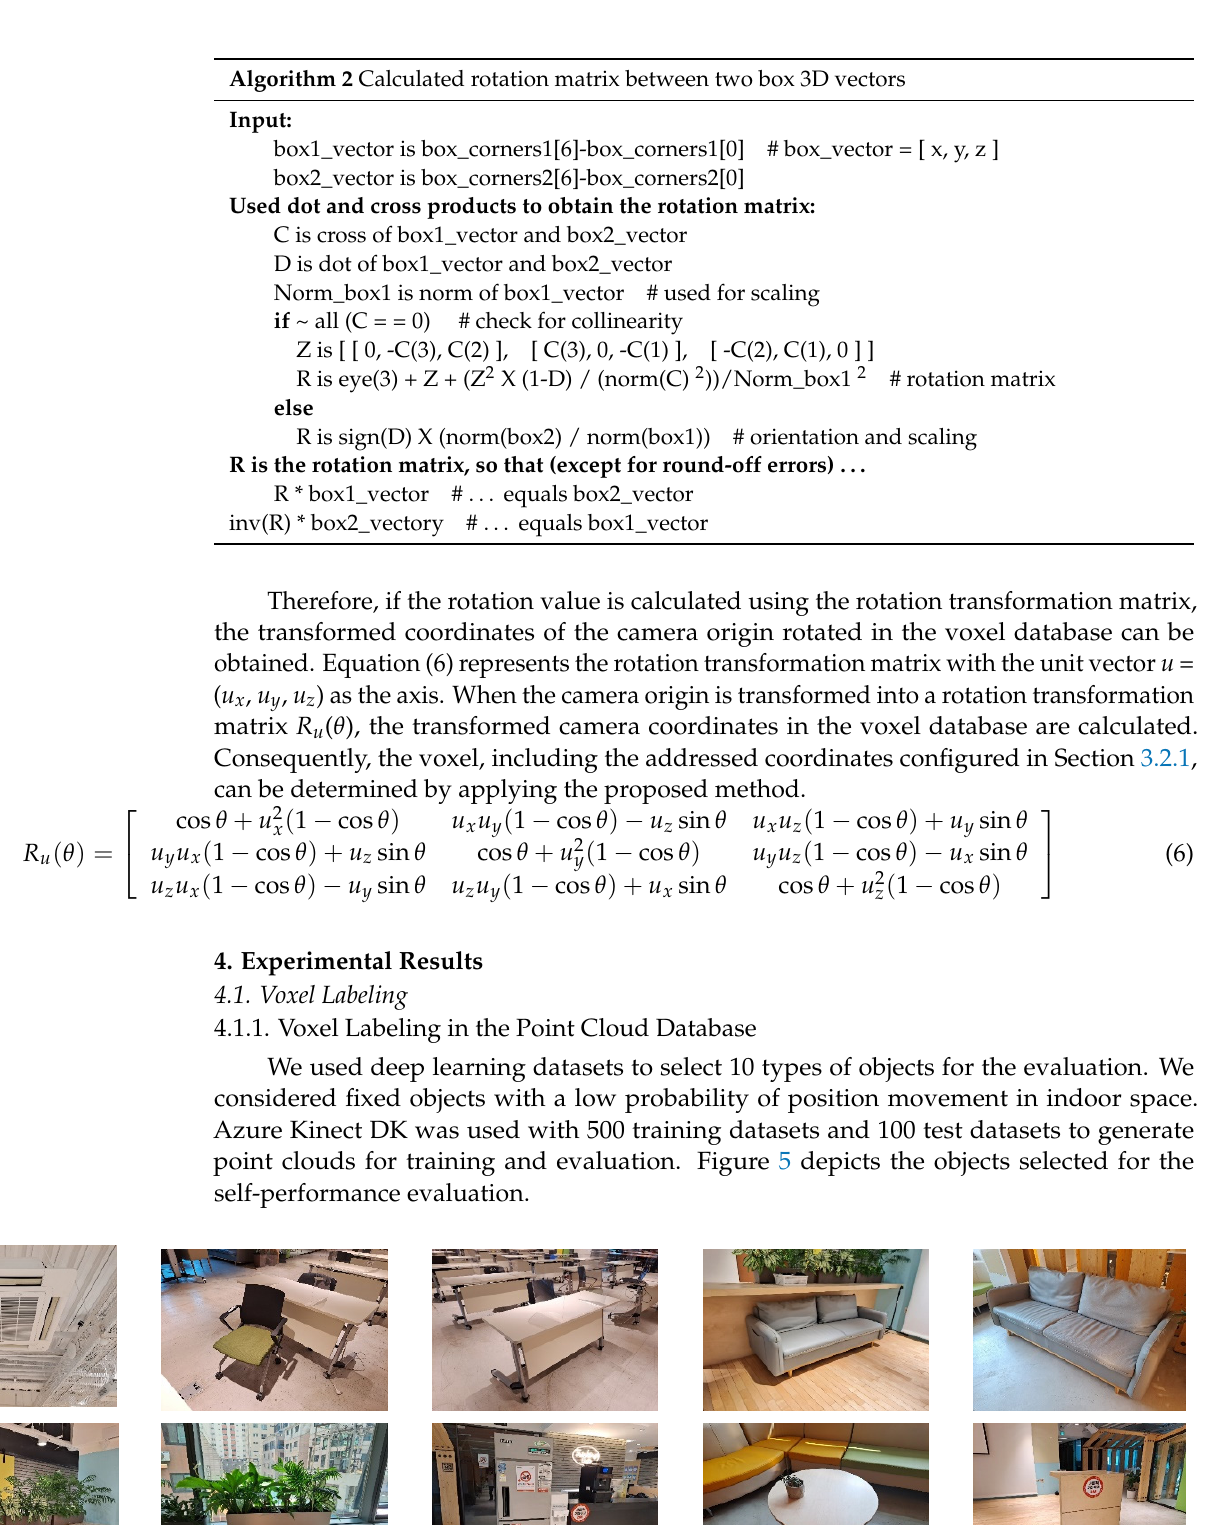
b Figure 6. ( a ) Learning labeling box of improved point-GNN and ( b ) key-point graph of object pose estimation.